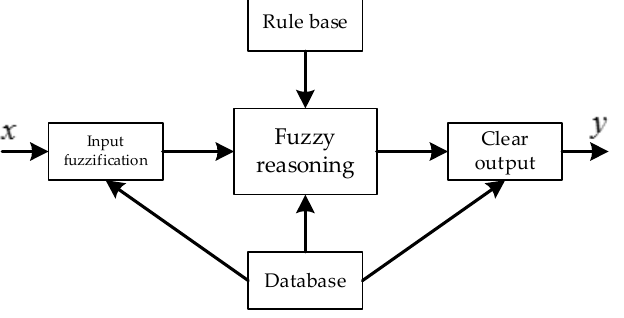
Figure 1. Composition of the fuzzy controller.